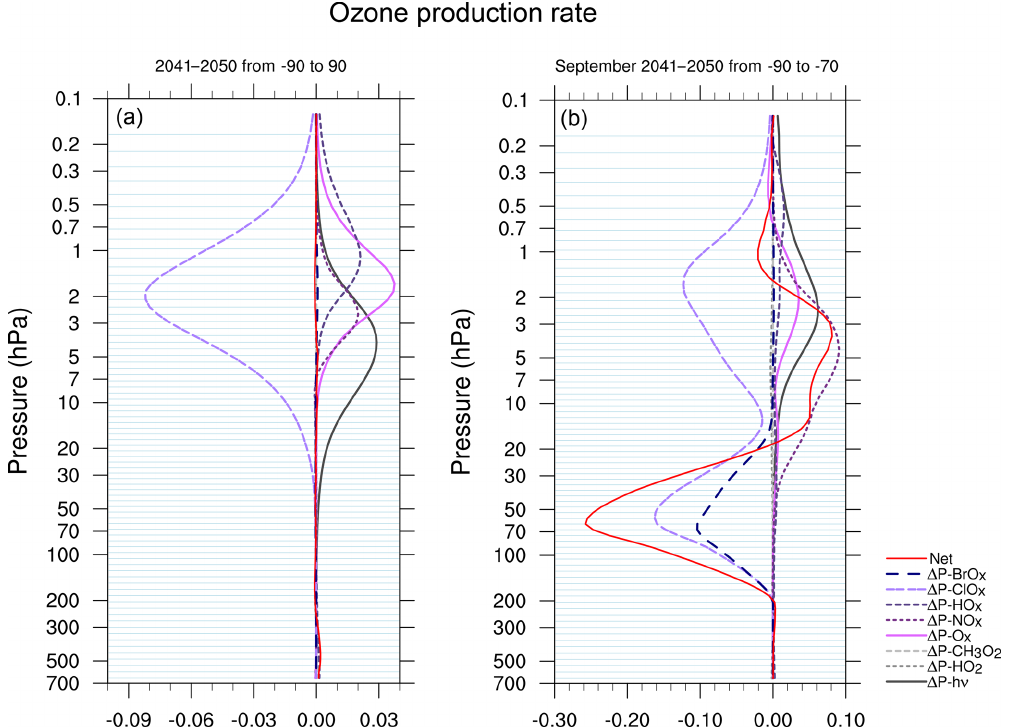
Figure 8. The relative change in ozone production rates (in %), which are normalized to the total column production (through photolysis h υ , HO 2 , and CH 3 O 2 ) in the REF-C2 simulation. For the individual ozone production and loss processes, mean differences are shown that have been derived from the REF-C2 and SEN-C2-fCFC11_2050 (i.e., SEN minus REF) simulations for the 2040s (from 2041 to 2050). The change in the net ozone production rate, which refers to the sum of all changes, is indicated by the red line. Panel (a) shows the mean annual global mean profiles, and panel (b) shows the values for the south polar region (70–90 ◦ S) in September. Negative values indicate an intensified ozone loss or a decreased ozone production in the SEN-C2-fCFC11_2050 simulation, whereas higher values indicate more ozone production or less loss via a specific process. Thin horizontal lines indicate the nearest pressure levels to the model grid